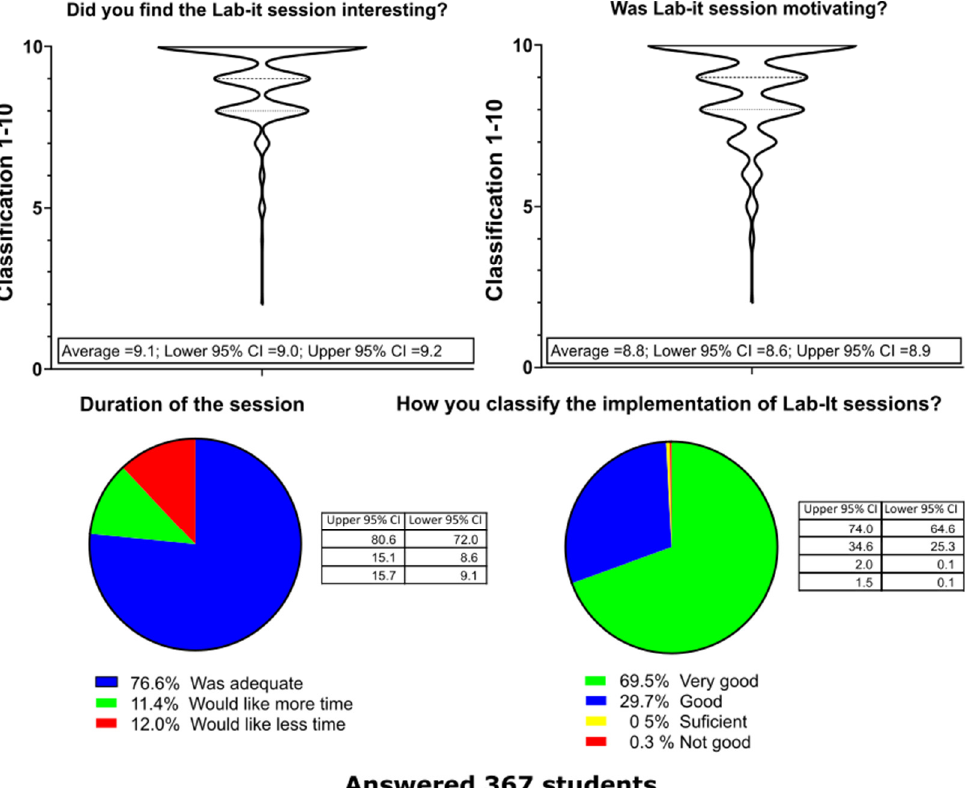
Figure 1. Opinion of students regarding the application of practical activities of